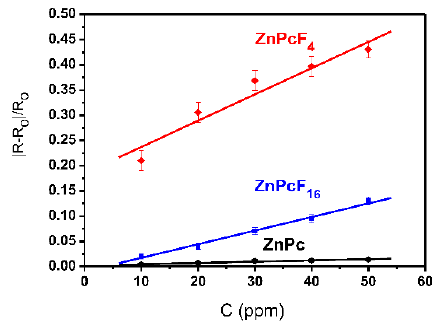
Figure 3. Dependence of the sensor response |R-R o |/R o on NH 3 concentration (10–50 ppm) for ZnPc, ZnPcF 16 , and ZnPcF 4 films.